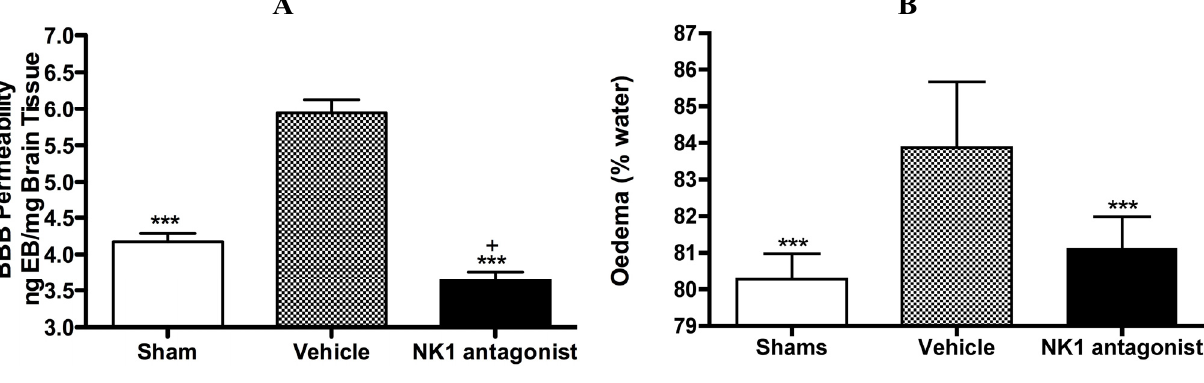
Figure 3. Marked BBB permeability, as measured by Evan’s Blue (EB) extravasation ( A ) and cerebral oedema, as measured by the wet weight-dry weight method ( B ) were observed at 24 h following stroke. This was ameliorated by treatment with an NK1 tachykinin receptor antagonist. *** p < 0.001 compared to vehicle; + p < 0.05 compared to